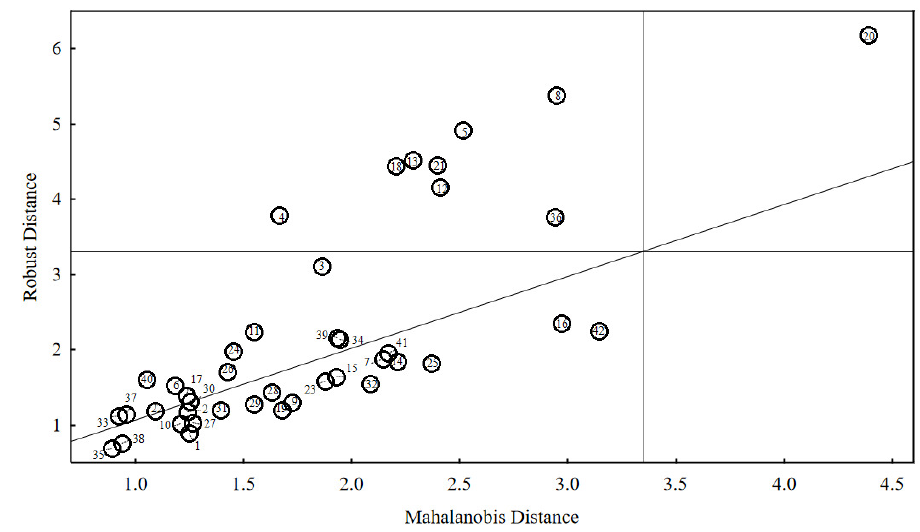
Figure 5. Mahalanobis distance plot.